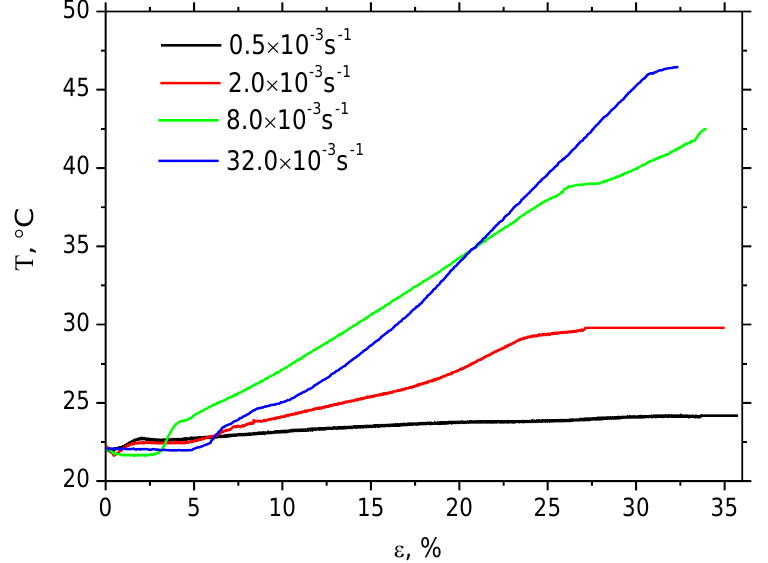
Figure 4. Evolution of temperature T as a function of plastic strain and strain rate.